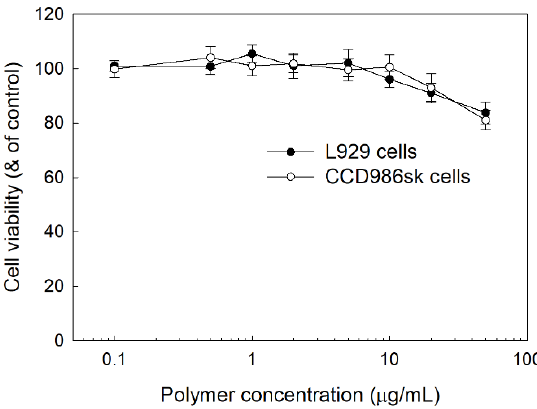
Figure 7. Cell cytotoxicity of LGseseTAPEG nanoparticles against L929 mouse fibroblast cells and CCD986sk human skin fibroblast cells. 2 × 10 4 cells in 96 wells were exposed to nanoparticles of LGseseTAPEG copolymer for 24 h. Cell viability was evaluated with an MTT assay.